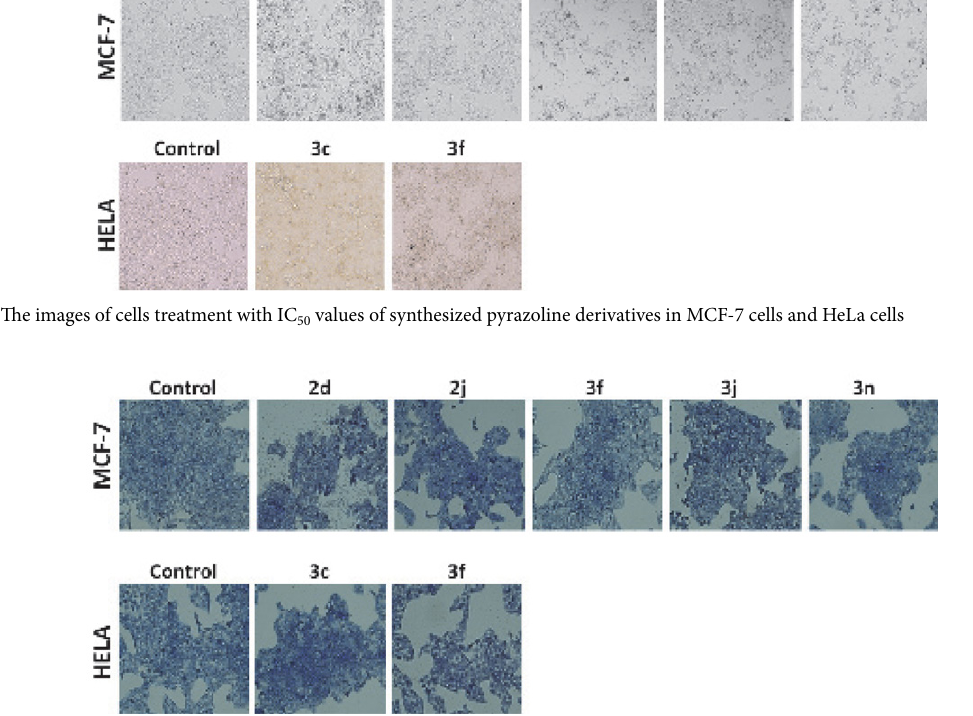
Figure 3. The colony formation images of MCF-7 cells and HeLa